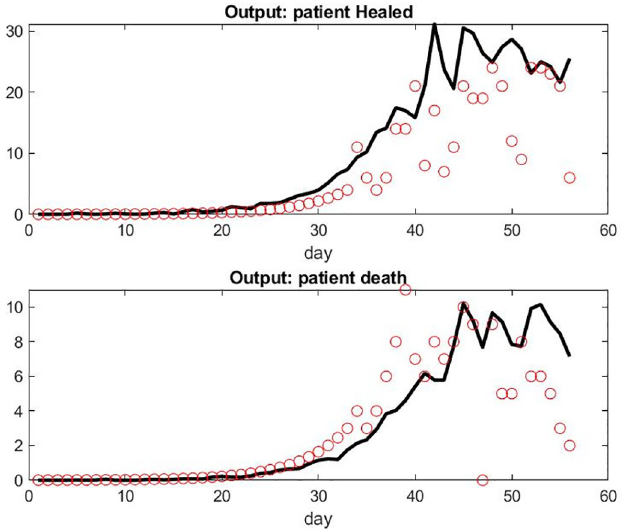
Fig 7. Top: Number of Patient Healed Leaving Hospital in Alsace, France per Day. Bottom: Number of Death per Day.